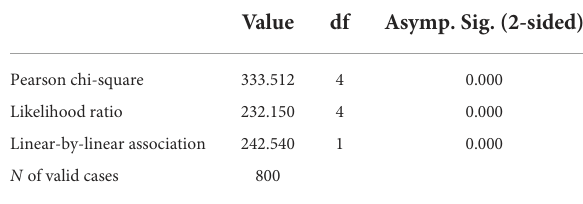
TABLE 2 Chi-square test between the dimension of responsiveness and satisfaction for the quality of services in public hospitals.